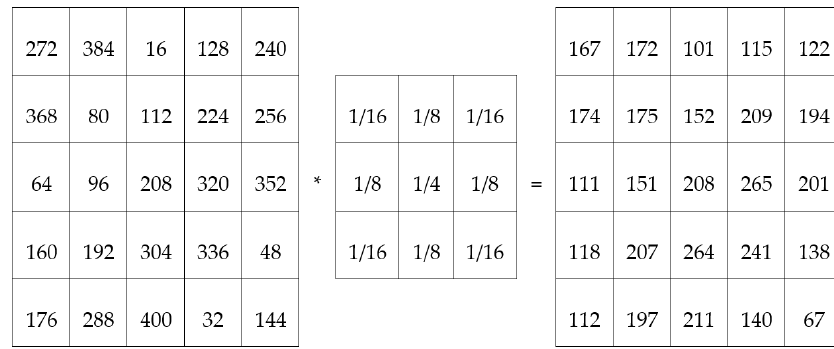
Figure 4. Gaussian convolution example.